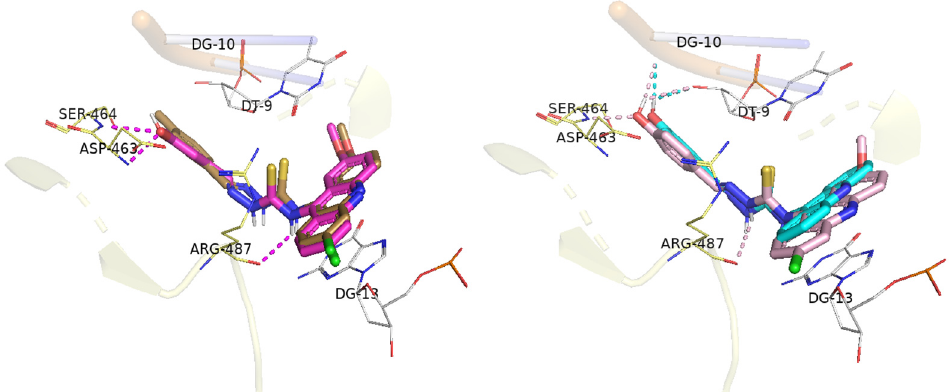
Figure 4. Final pose of molecular docking for acridine–thiosemicarbazone derivatives with DNA– Topo II α . On the left, final conformers of DL-06 (bronze-yellow) and DL-08 (magenta) complexed with human DNA–Topo II α (PDB ID: 5gwk); on the right, a detailed illustration of the intermolecular interactions of DL-07 (light pink) compared to CL-07 (cyan). The dashes indicate the polar interactions made by each structure with the receptor and follow their respective colors.